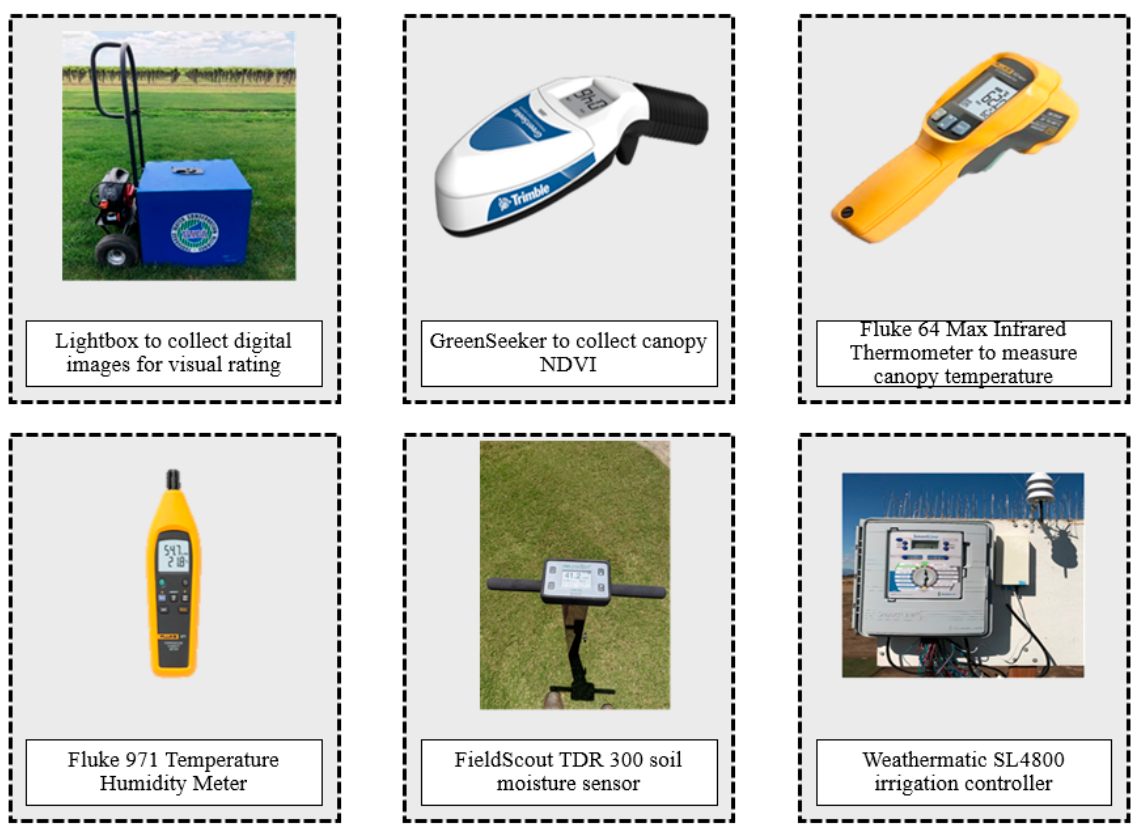
Figure 3. An overview of the sensors and tools used in this study and the companion paper [23].